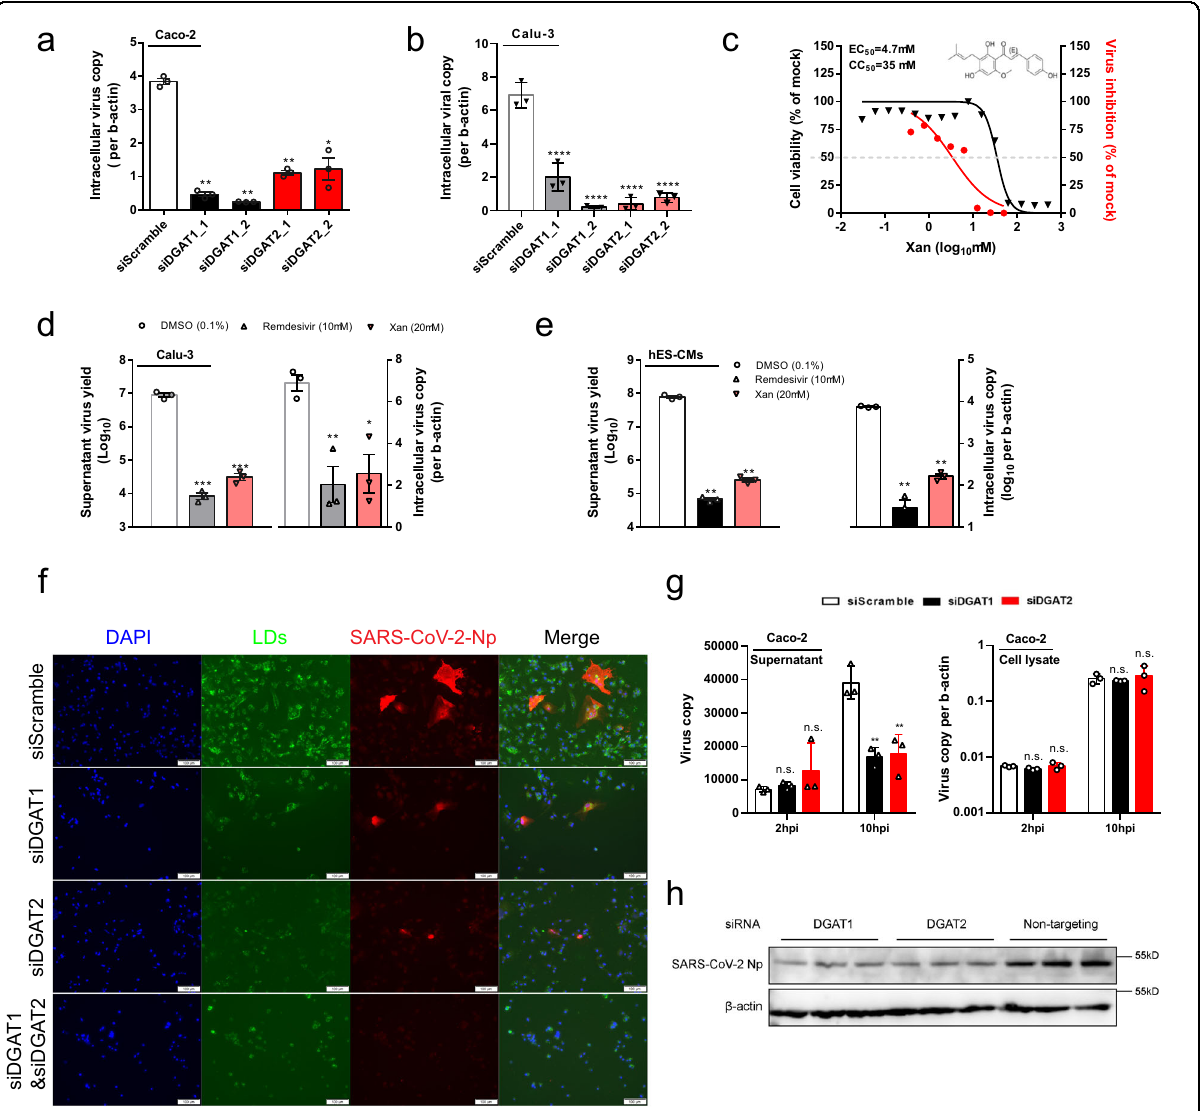
Fig. 3 DGATs are potential therapeutic targets for COVID-19. a , b DGAT genes are required for SARS-CoV-2 replication. siRNA knockdown of either DGAT1 (two distinct siRNA 1_1 and 1_2) or DGAT2 (siRNA 2_1 and 2_2) were performed on human colorectal Caco-2 ( a ) or lung Calu-3 cells ( b ) before virus infection for 48 h (0.1 MOI). Viral yields in the cell lysate were determined by RT-qPCR and normalized with human β -actin. One-way ANOVA was used for comparison with the scramble siRNA pre-treated group. c Dose – response analysis of the compound Xanthohumol is shown, depicting both antiviral activity (red) and cytotoxicity (black). The gray dash line indicates 50% of the mock-treated control with EC 50 , CC 50 , and chemical structure displayed. d Xanthohumol inhibited SARS-CoV-2 replication in Calu-3 cells that were infected by 0.1 MOI SARS-CoV-2. Viral loads in the cell supernatant and cell lysate were determined at 48 hpi by RT-qPCR assays, respectively. Data represent means ± SD. One-way ANOVA was used for comparison with the DMSO control group. e Xanthohumol inhibited SARS-CoV-2 replication in human embryonic stem cells-derived cardiomyocytes (hES-CMs) that were infected by 0.1 MOI SARS-CoV-2. Viral loads in the cell supernatant and cell lysate were determined at 24 hpi by RT-qPCR assays, respectively. Data represent means ± SD. One-way ANOVA was used for comparison with the DMSO control group. f siRNA-treated- Huh7 cells were infected with SARS-CoV-2 (10 MOI for 12 h) before staining with DAPI (blue), viral nucleocapsid protein (NP) (red), and BODIPY 493/ 503 lipid probe (green) for LD detection. Scale bar: 100 µm. g Knockdown of DGAT1/2 reduced viral yields in the cell culture supernatant but not cell lysate. A single-cycle SARS-CoV-2 replication assay was performed in Caco-2 cells transfected with the indicated siRNA. Viral yields in the cell lysate and supernatant were determined by RT-qPCR. Data collected at 2 hpi were taken as a baseline and at 10 hpi taken as the completion time for one virus life cycle 2 . One-way ANOVA was used for comparison with the scrambled siRNA pre-treated group. For all statistical analyses, * P < 0.05, ** P < 0.01, *** P < 0.001, **** P < 0.0001, n.s. indicates P > 0.05. h Cell lysate at 10 hpi was also utilized for western blotting detecting SARS-CoV-2 NP and host β -actin. Shown are triplicates (i.e., three different siRNAs) of each